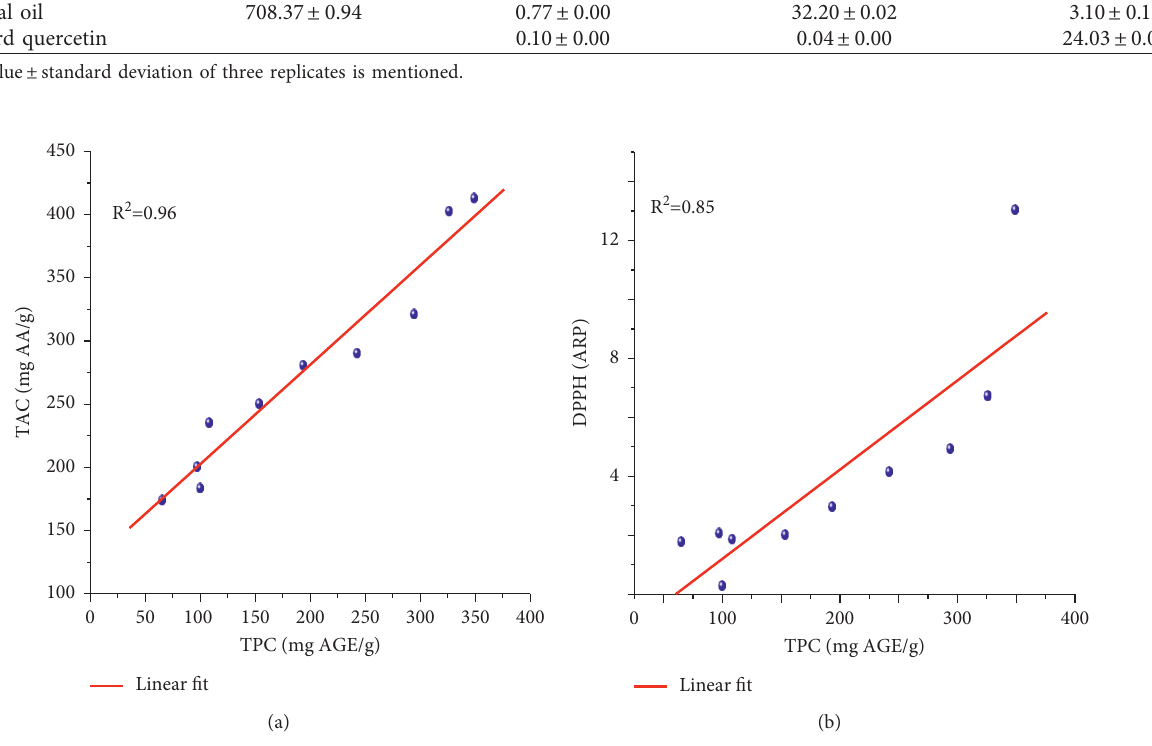
50 ), efficient concentration (EC 50 ), and antiradical power (ARP) of